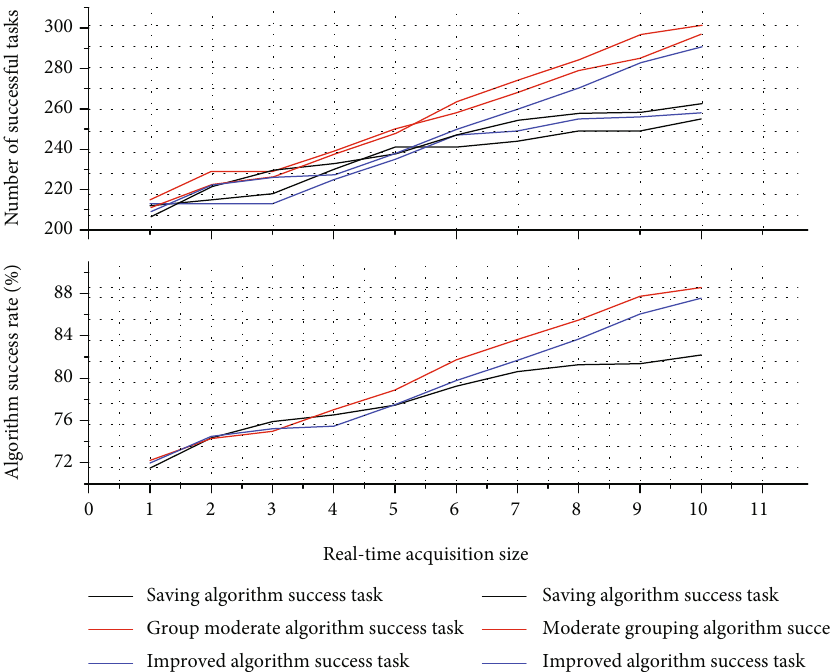
Figure 3: Comparison of scheduling success rate of di ff erent scheduling